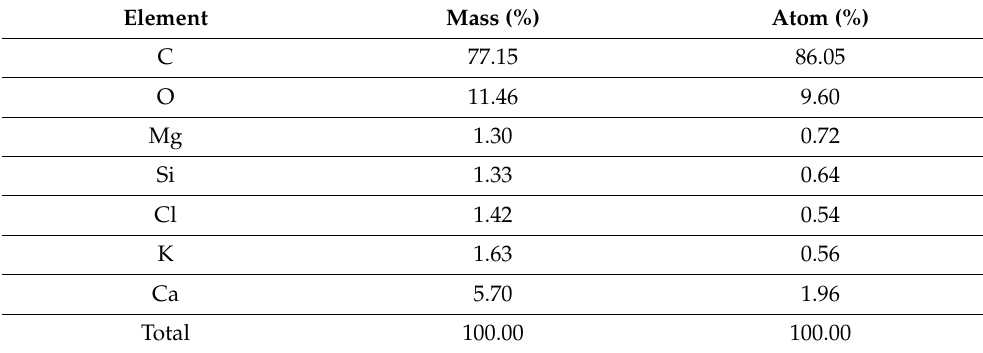
Table 2. The surface element analysis of AC-RGL adsorbent.